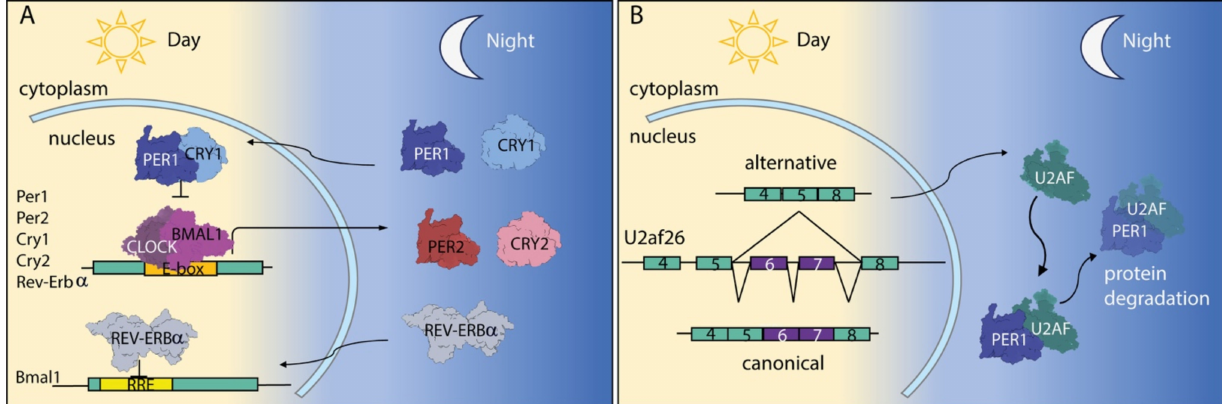
Figure 4. The circadian clock and RNA processing regulation. ( A ) Schematic representation of the circadian clock pathway. Upon circadian stimulation, the two transcription factors CLOCK and BMAL1 form a complex that binds the E-box motif in the promoter region of their target genes (such as PER1/2 CRY1/2 and Rev-Erb α ) inducing their transcription. PER1 and CRY1 proteins then translocate into the nucleus to form a complex and repress CLOCK:BMAL1, thus forming a negative feedback mechanism that controls the pathway. In parallel, REV-Erb α translocates into the nucleus and contributes to repression of the transcription of BMAL1. ( B ) The U2AF26 transcript is alternatively spliced to yield two different isoforms, whose expression follows the circadian rhythms: the canonical isoform that includes exon 6 and 7 (purple exons) and the alternative one skipping them. The alternative isoform leads the formation of a different domain at the C-terminus, resulting in a new interaction of this splicing regulator with PER1 and promoting its